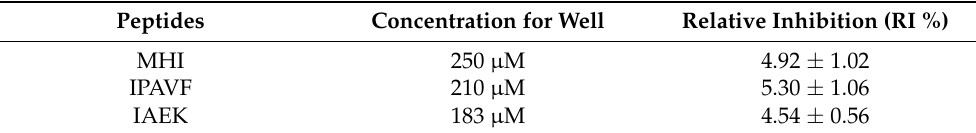
Table 3. The relative inhibition percentage (RI %) of HRV 3C protease by the assayed small peptides.